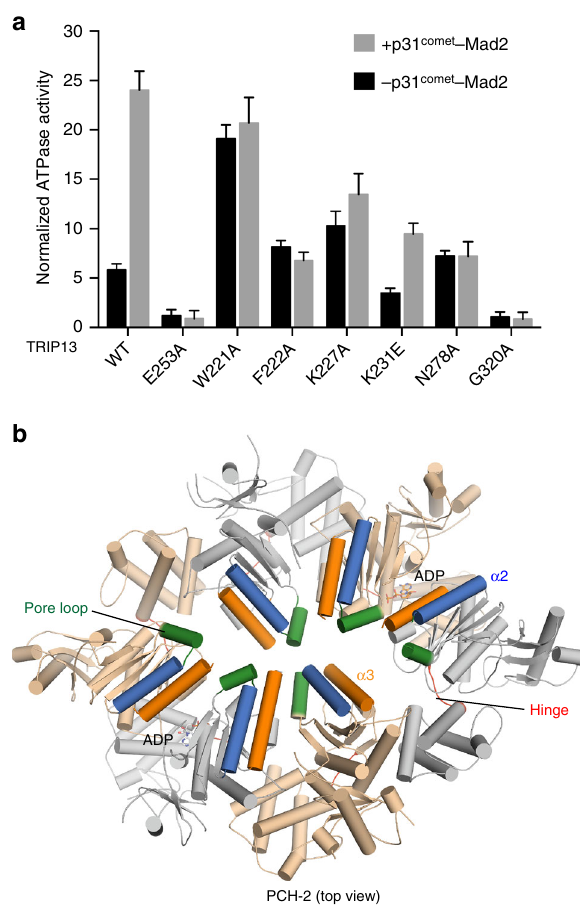
Fig. 4 Identi fi cation of TRIP13 mutants with defective p31 comet – Mad2 stimulation. a Normalized ATPase activities of the indicated TRIP13 proteins at 25 nM with (+) or without ( − ) 50 nM Δ N35- p31 comet – Mad2 L13A . Mean ± SD; n = 9. b Cartoon diagram of C. elegans PCH-2 in the top view. The pore loop, the α 2 helix, the α 3 helix, and the hinge are shown in green, blue, orange, and red, respectively. The bound ADP molecules are shown in